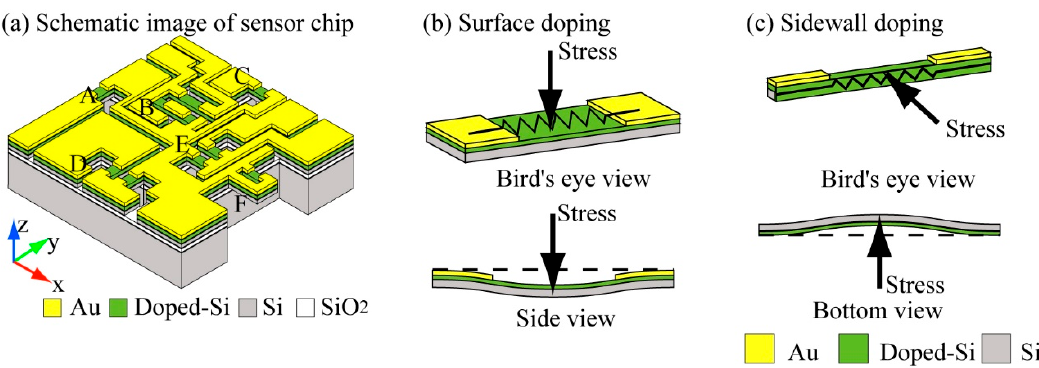
Figure 1. Schematic images of the proposed tensor sensor. ( a ) whole image of the sensor chip, ( b ) structure and deformation image of a surface doped silicon beam, and ( c ) structure and deformation image of the sidewall doped silicon beam.